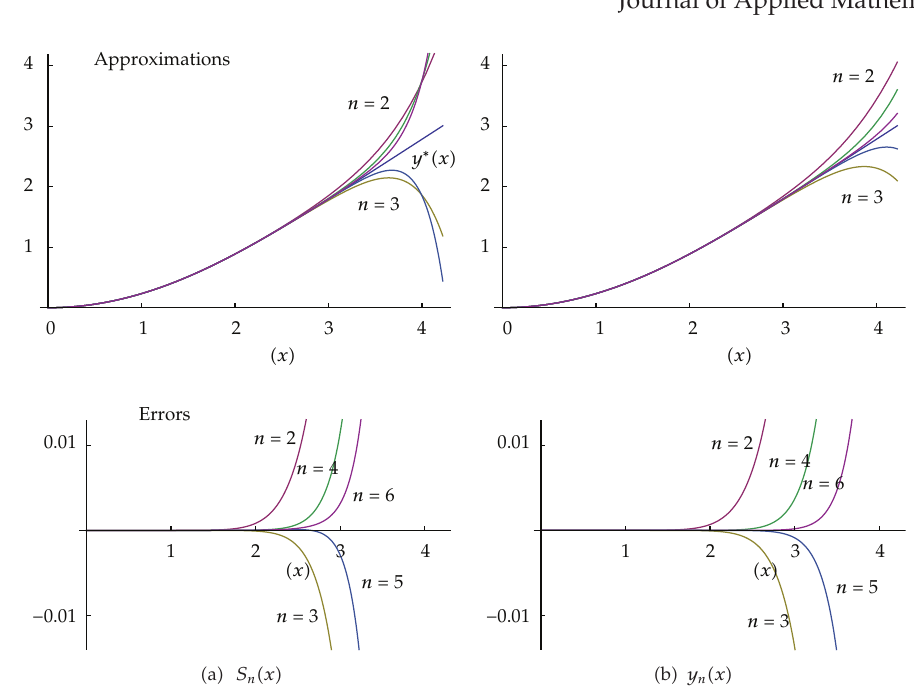
Figure 1: Truncated Blasius series S n (cid:3) x (cid:4) and their errors in (cid:3) a (cid:4) and presented solutions y n (cid:3) x (cid:4) and their errors in (cid:3) b (cid:4) , n (cid:6) 2 , 3 , 4 , 5 , 6, for the Blasius equation (cid:3) β (cid:6) 0 (cid:4)